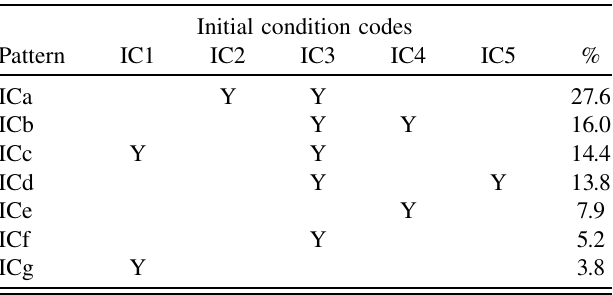
TABLE III. Only seven of the 14 distinct code patterns for the IC category (Table II) were populated by more than 3% of the students. The patterns (ICx) are given by affirmatives (Y) and negatives (blank) in the code columns (IC#). The percentage of students with each pattern is indicated by the last column (%).